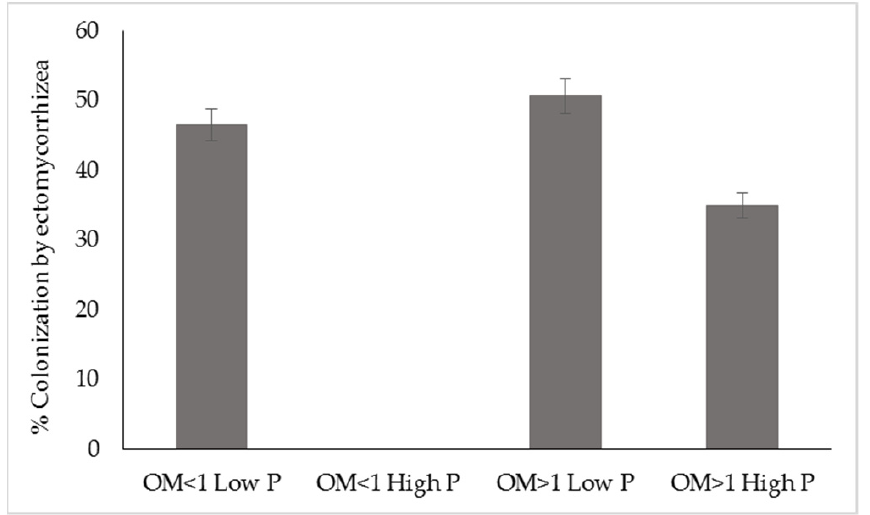
Figure 4. Correlation of the contents of organic matter (%) and phosphorus (ppm) in the rhizospheric soil with the percentage of ECM colonization ( p ≤ 0.05) in the roots of pecan trees in orchards established in Chihuahua State, Mexico. OM < 1Low P = organic matter ≤ 1% and phosphorus ≤ 22 ppm. OM < 1 High P = organic matter ≤ 1% and phosphorus > 22 ppm. OM >1 Low P = organic matter > 1% and phosphorus ≤ 22 ppm. OM>1 High P = organic matter > 1% and phosphorus > 22 ppm. 3.3.3. Texture The highest ECM percentages correlated with sandy clay crumb texture soils with an average of 55% ECM, followed by clay loam soils with 49.5% ECM. The soils with loam and clayey texture had the lowest levels of ECM, with 31.4 and 34%, respectively (Table 2).